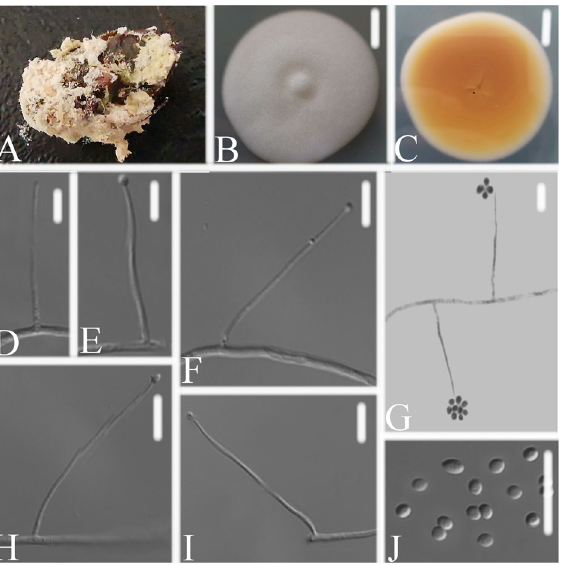
Figure 6. Simplicillium scarabaeoidea (A) infected scarab (Scarabaeoidea) (B,C) culture plate, showing the front (B) and the reverse (C) of the colony, cultured on PDA medium (D–I) phialides solitary, conidia adhering ellipsoidal slimy head and conidia (J) conidia. Scale bars: 10 mm (B,C) , 10 μm (D–J)